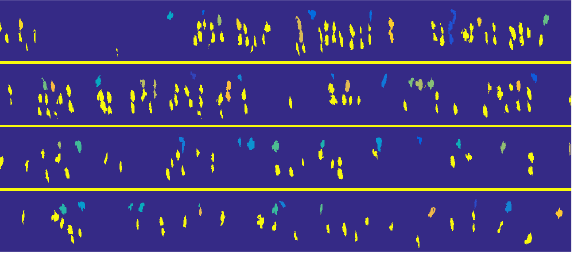
Figure 6. Time series of dense traffic of the corridor profile scan- ning with all pedestrian